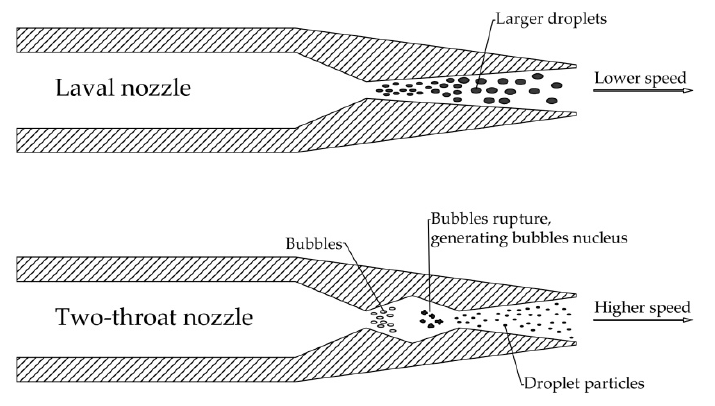
Figure 1. Schematic diagram of a two-throat nozzle and a Laval